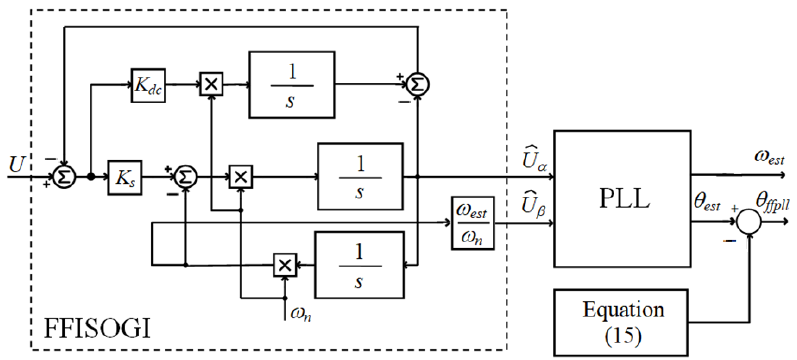
Figure 7. The improved FFPLL1 with the DC offset compensation.